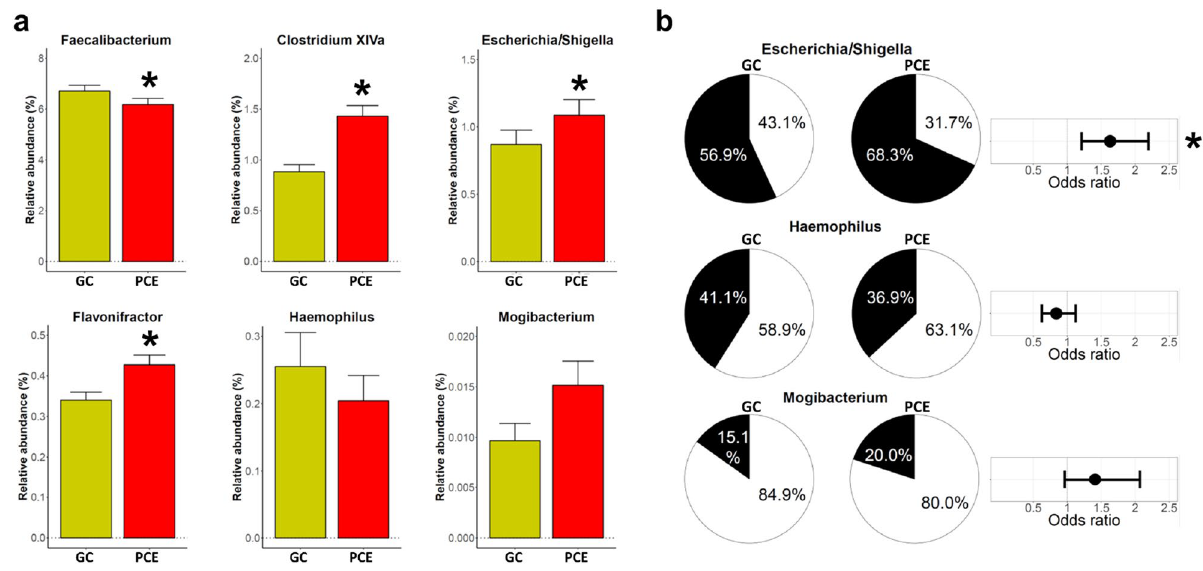
Figure 4. Differences in intestinal microbiota composition between individuals post-cholecystectomy (PCE) and gallstone carriers (GC). ( a ) Barplots (mean + sem) display taxon abundance of the PCE subsample (n = 404, red) and GC cases (n = 404, yellow). ( b ) Pie charts are displaying the fraction of non-zero samples (in black) of the PCE subsample and GC cases. The odds ratios represent the reduced or increased likelihood of the respective taxon to be present in the PCE subsample compared to GC cases. *Indicates a significant